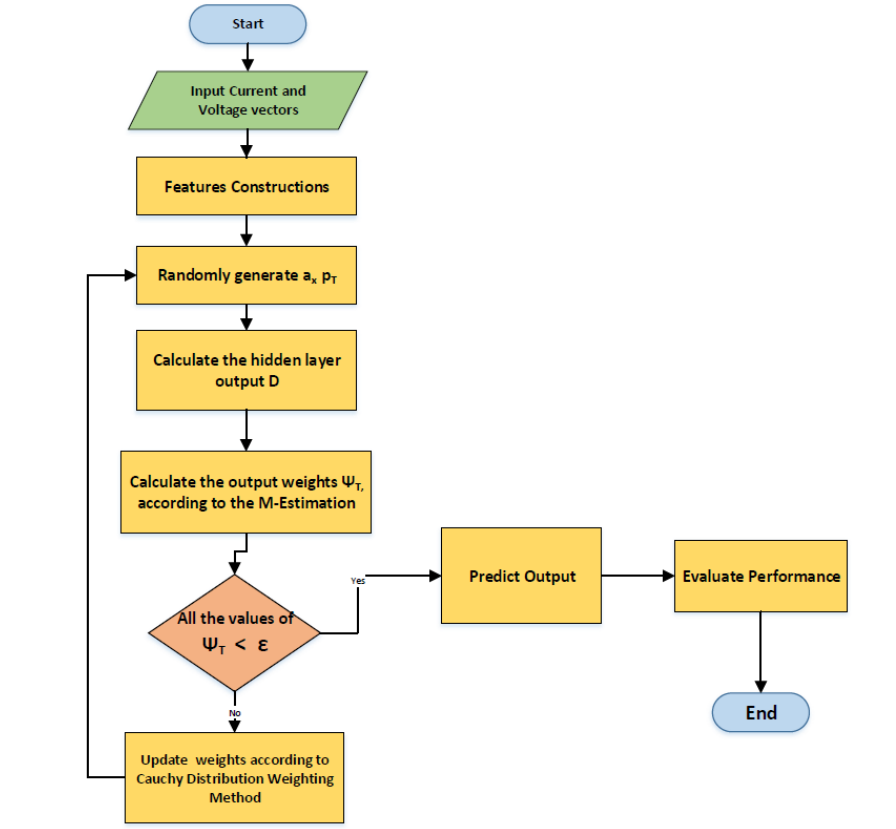
Figure 2. Flow chart of the Cauchy Distribution M-estimate